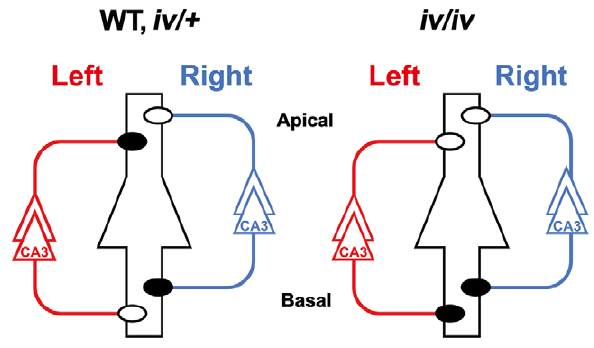
Figure 1. Hippocampal asymmetry and right isomerism of the iv/iv mouse hippocampus. Left and right CA3 pyramidal neurons and their axons are colored red and blue, respectively. A postsynaptic CA1 pyramidal neuron is at the center, colored black, and it represents postsynaptic neurons in both left and right hemispheres. Closed and open circles represent e 2-dominant and e 2-nondominant synapses, respectively. Apical, apical dendrites; Basal, basal dendrites.